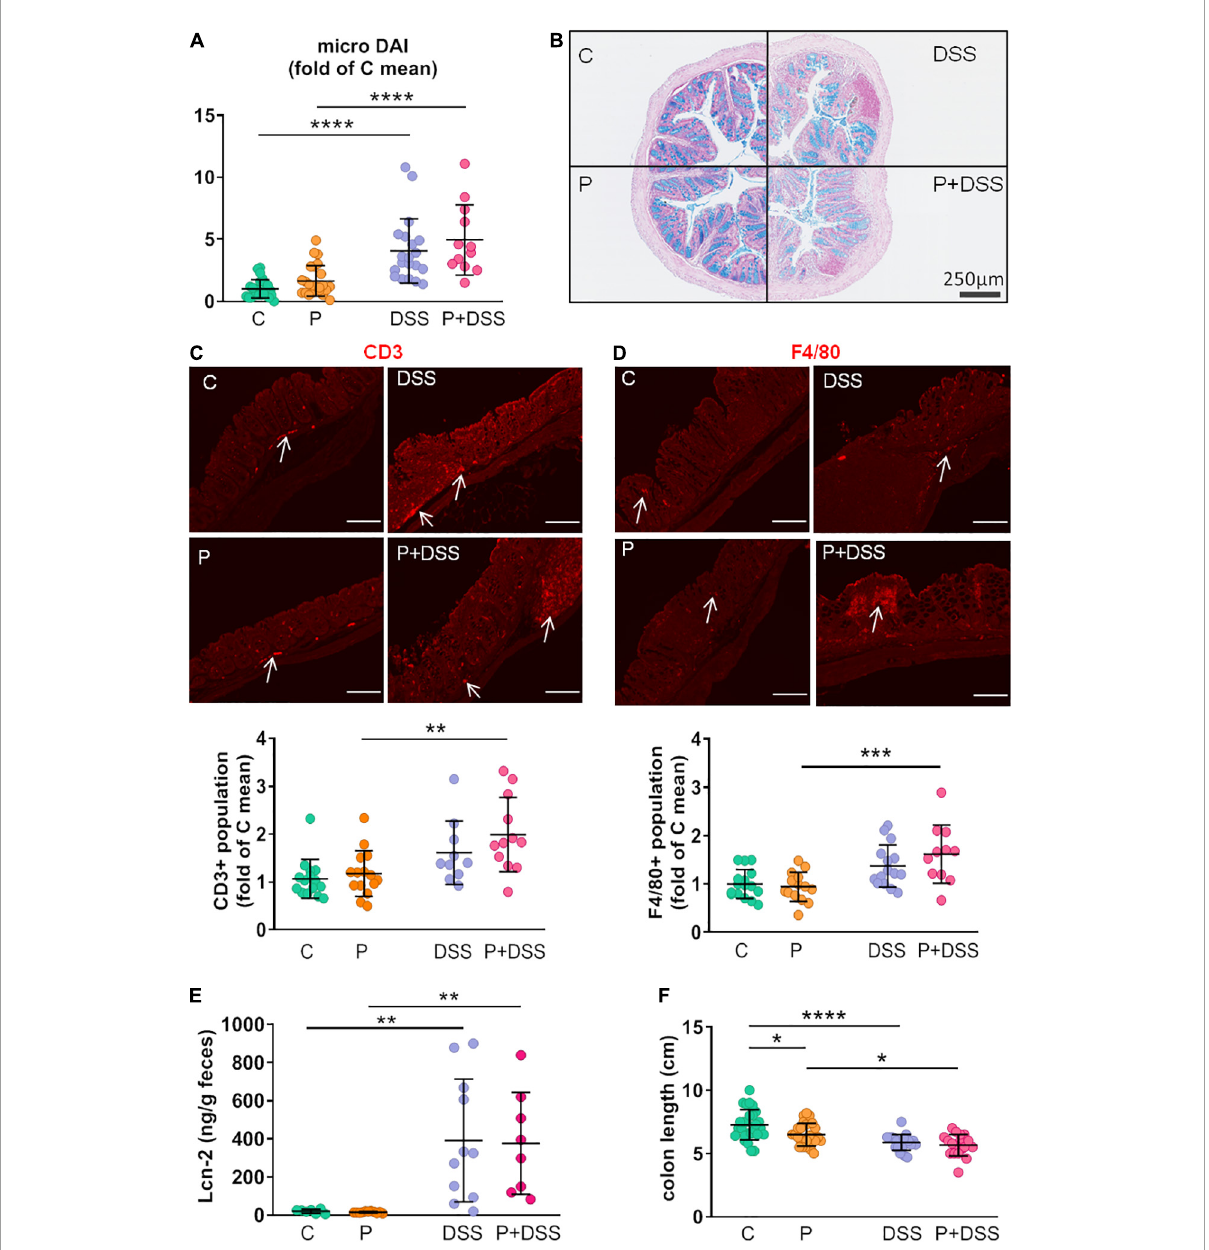
FIGURE2 Prebiotic administration to mothers increases colon shortening and DSS-induced immune cell infiltration, but not global inflammation or tissue remodelling, in the offspring. Colon remodelling was evaluated through calculation of the (A) histological score (micro–DAI), representing the destruction of mucosal architecture, muscle thickening, loss of goblet cells, and cellular infiltration, after haematoxylin–phloxine–saffron (HPS) and alcian blue staining of distal colon sections ( B representative pictures of the sections for each group of mice). N = 12–25 mice/group. Precise immune cell infiltrations were evaluated via immunostaining of CD3 (T cells; C ) and of F4/80 (macrophages; D ) in distal colon sections. N = 10–15 and 11–16 mice/group, respectively. Scale bar = 100 µ m. Global intestinal inflammation was evaluated in all four groups of mice through the measurement of lipocalin-2 (Lcn-2; E ) faecal content and colon shortening (F) . N = 7–11 and 18–27 mice/group, respectively. Data represent the mean and standard deviation of the mean. Two-way ANOVA, followed by Bonferroni’s post hoc comparisons tests: * p < 0.05, ** p < 0.01, *** p < 0.001, **** p < 0.0001 (Prebiotics or DSS effect).